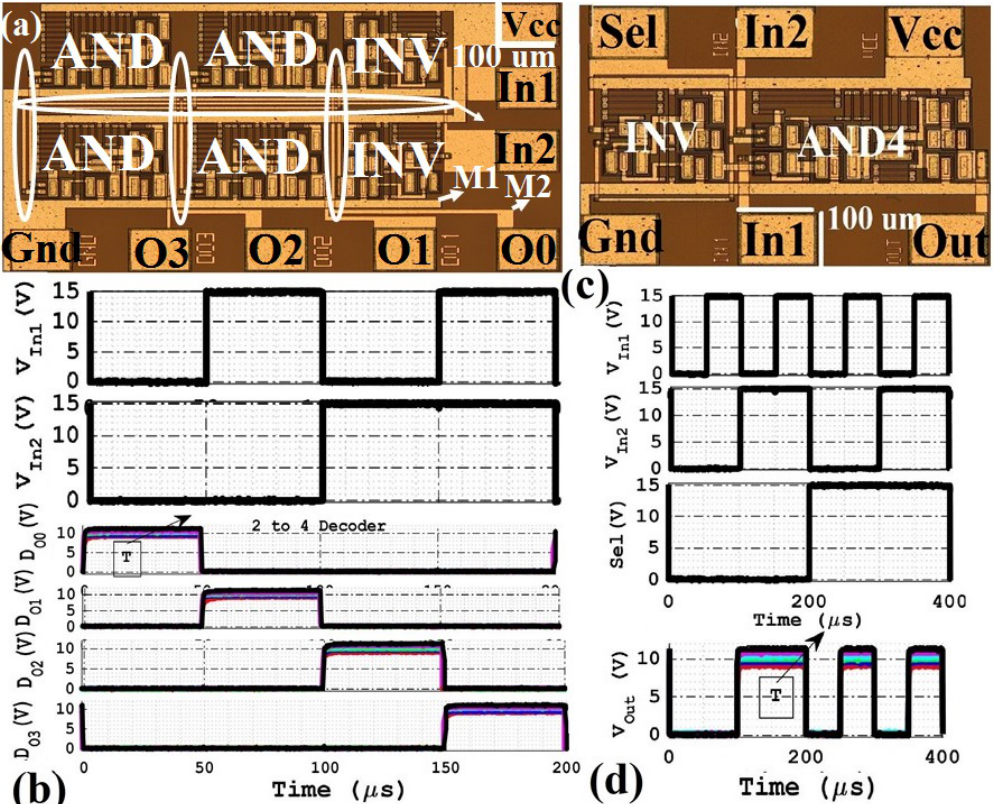
Figure 15. SiC TTL-based 2–4-line decoder and 2–1-line multiplexer realized in SiC TTL PDK. ( a ) Decoder micro-photograph ( b ) measured transient-response in the range of 25–500 ○ C by applying f in 1 = 10 kHz f in 2 = 5 kHz with V IH = 15 V and V IL = 0 V at input. ( c ) 2–1 Multiplexer micro-photograph ( d ) MUX measured transient-response in the range of 25–500 ○ C by applying f in 1 = 10 kHz f in 2 = 5 kHz as input and f in 3 = 10 kHz as a select line with V IH = 15 V and V IL = 0